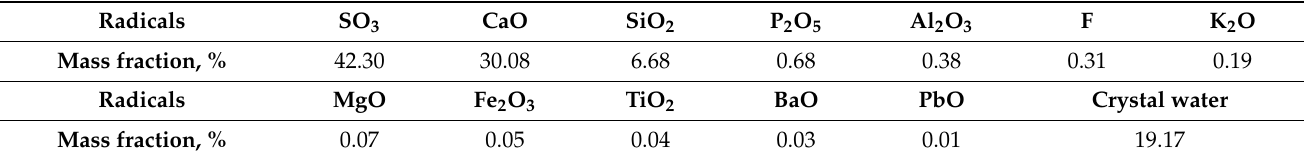
Table 1. Chemical composition of the PG analyzed by XRF (%).